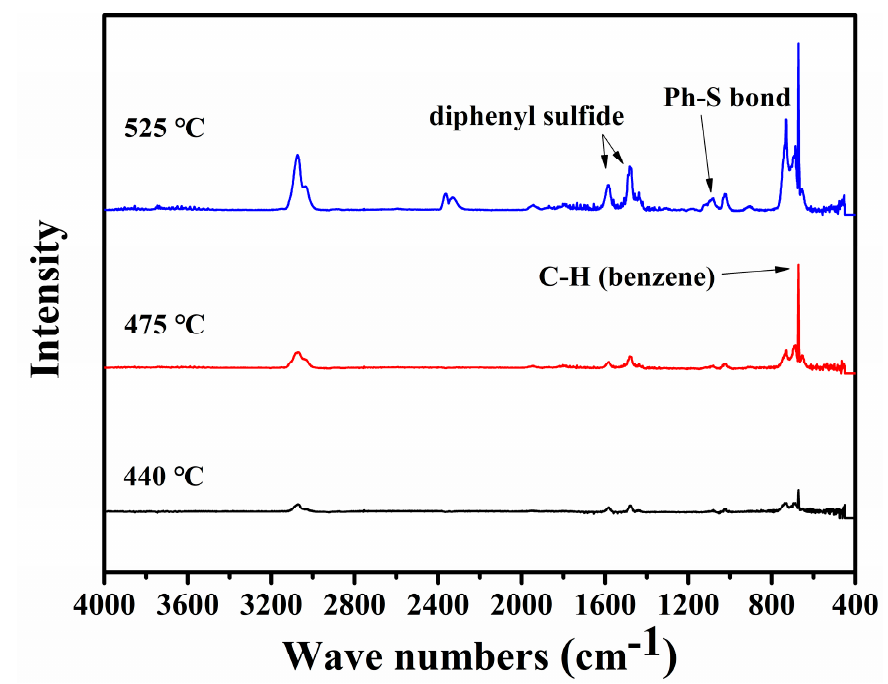
Figure 2. FTIR spectra of gaseous products of sodium thiophenolate.